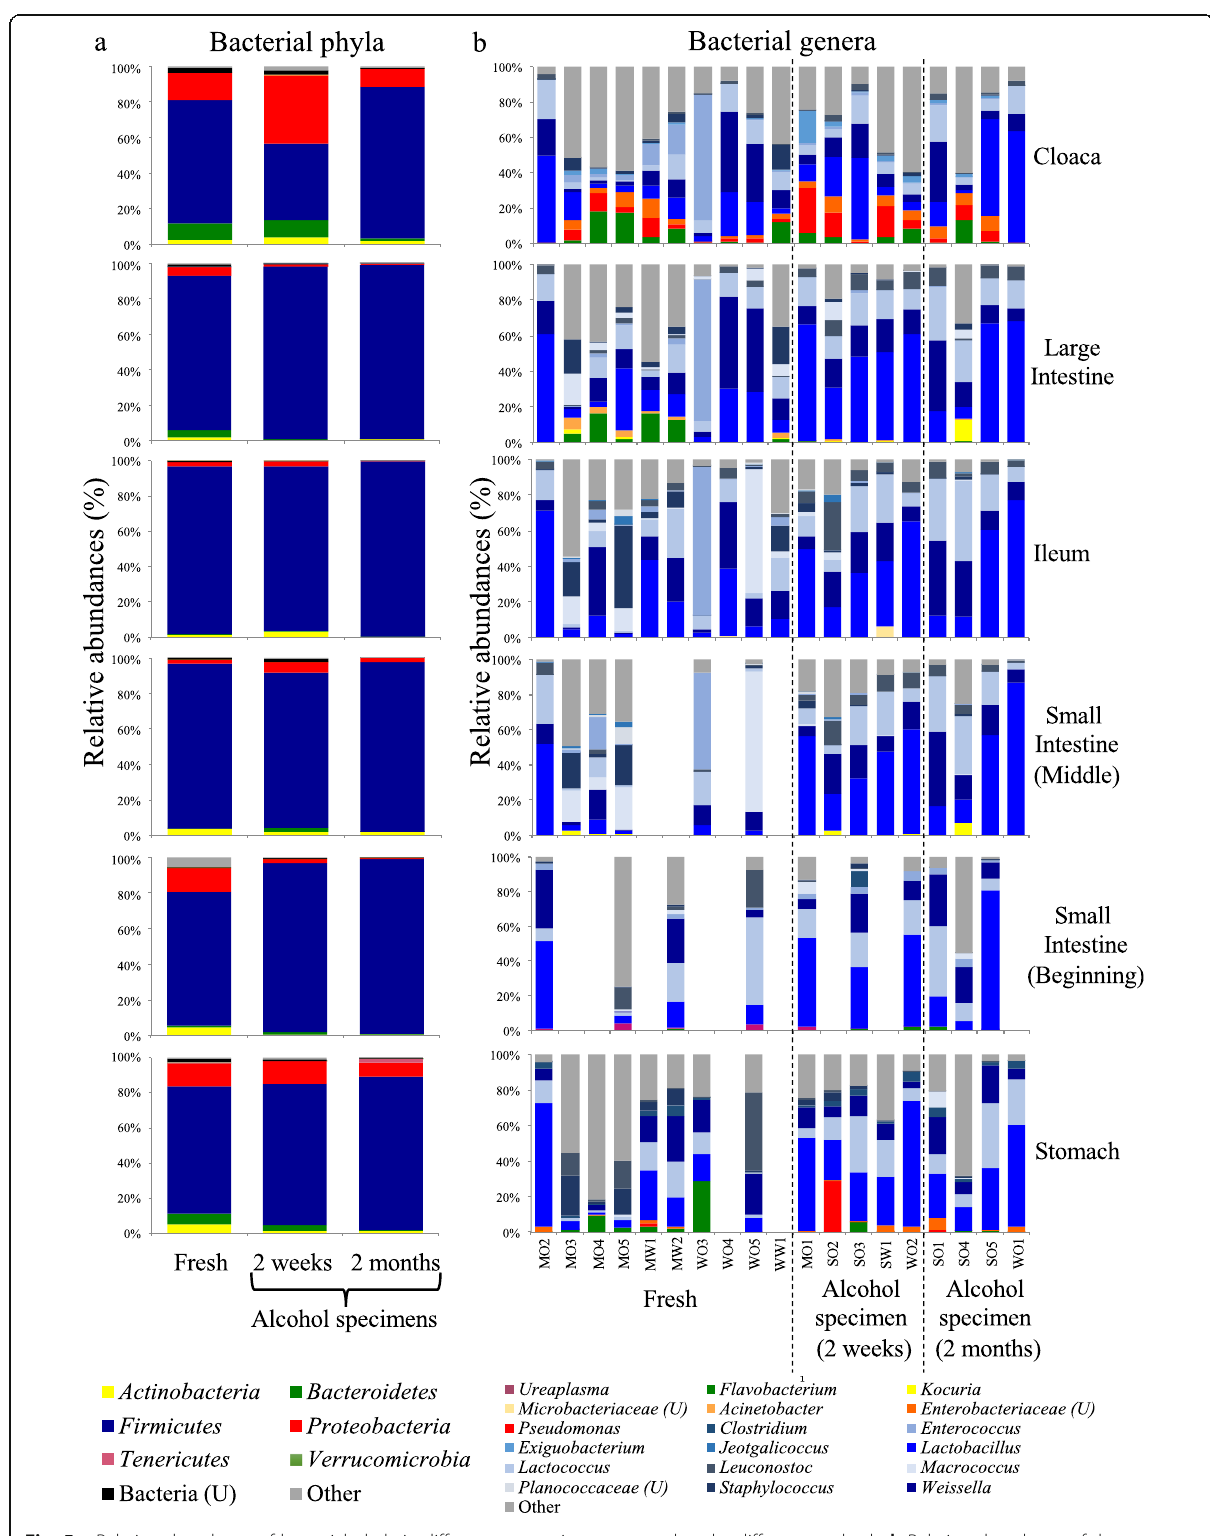
Fig. 5 a Relative abundance of bacterial phyla in different gut sections preserved under different methods. b Relative abundance of the ten most common bacterial genera (accounting for a total of 88.5% of sequences in the data set) across compartments and preserved under different conditions. Each column represents different gut sections from an individual. U = unclassified genera within the given